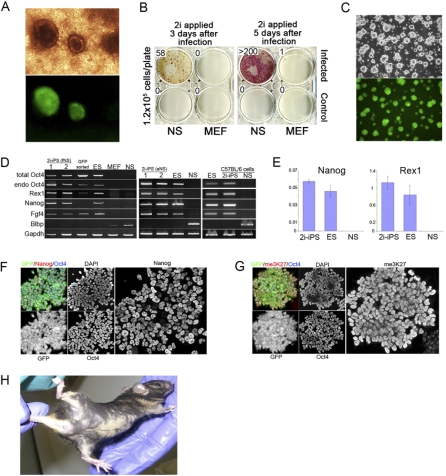
MEK and GSK3 Inhibitors (2i) Promote Reprogramming to Full Pluripotency(A) Example of 2i-iPS cell colonies generated from aNS cells replated at day 5 after infection in 2i medium.(B) Plates containing control and infected aNS cells and MEFs were cultured in 2i media from day 3 or day 5 after infection and stained for AP 10 d later. Numbers of AP-stained colonies are indicated.(C) Established 2i-iPS cell line.(D and E) Conventional (D) and quantitative (E) RT-PCR analyses of 2i-iPS cells generated from aNS and fNS Oct4GFP NS cells, and from fNS cells of non-transgenic C57BL/6 strain background.(F) Immunofluorescence staining for Oct4 and Nanog in 2i-iPS cell colony after first passage.(G) Immunostaining forme3K27. A cluster of residual Oct4-negative cells retains the nuclear body of an inactive X chromosome, providing an internal control.(H) Chimera generated from injection of 2i-iPS (aNS) cells into C57BL/6 host blastocyst.